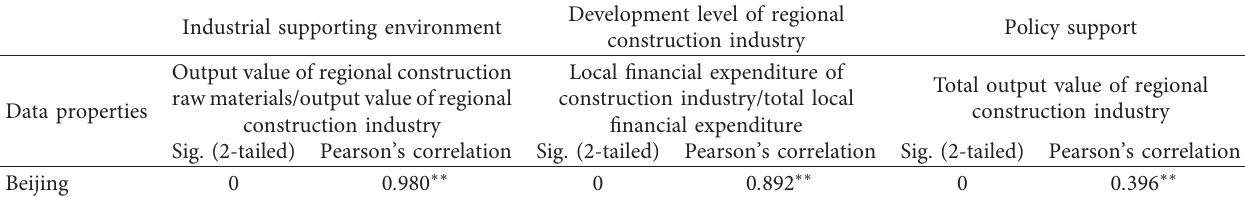
Table 4: Correlation coefficient